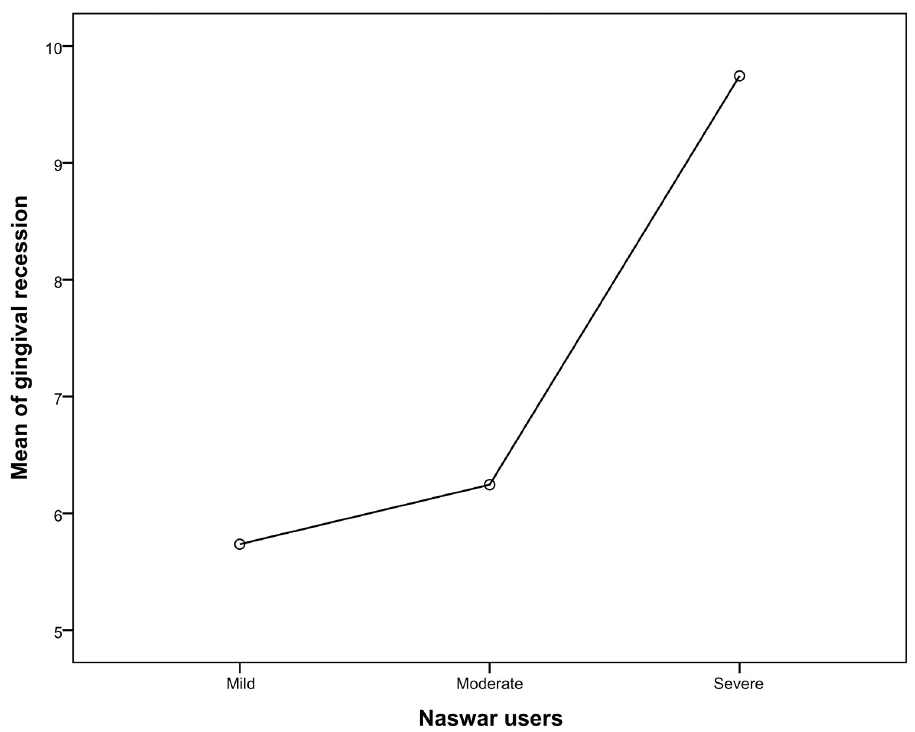
Fig 6. Mean score of gingival